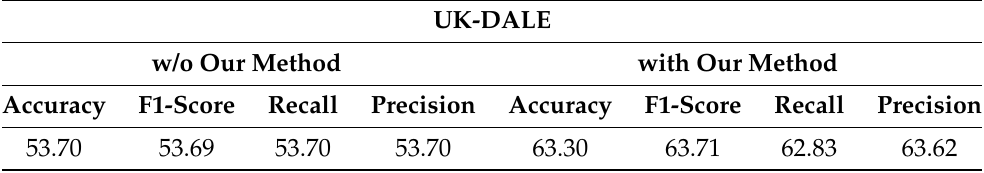
Table 9. The results of combinations of five appliances with VDOCNN (UK-DALE).